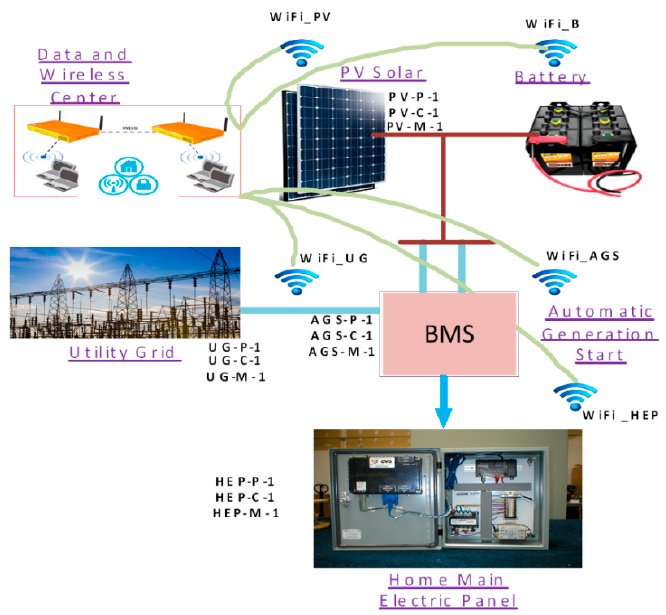
Figure 1. Battery Management System (BMS) connections and integrations [5].